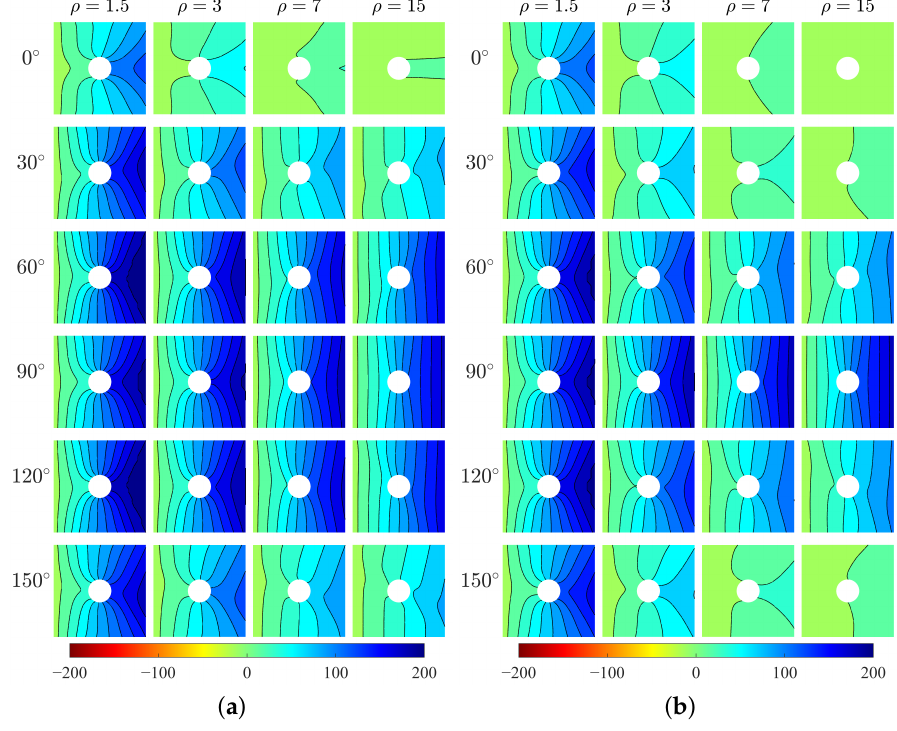
Figure 3. Horizontal displacement u 1 , mm, ( a ) Cosserat, ( b )